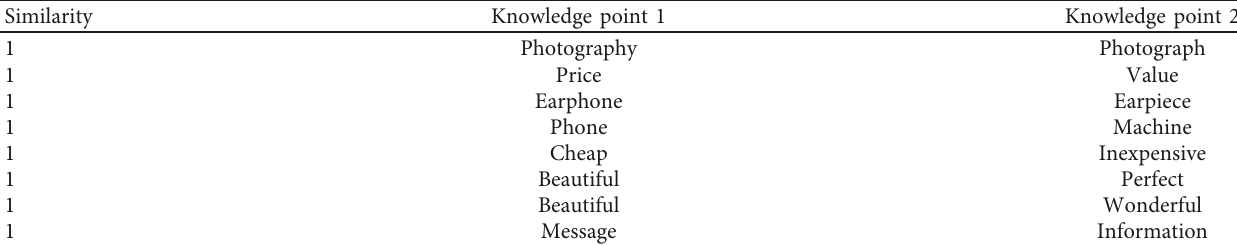
Table 6: Example of some synonymous knowledge point keywords.